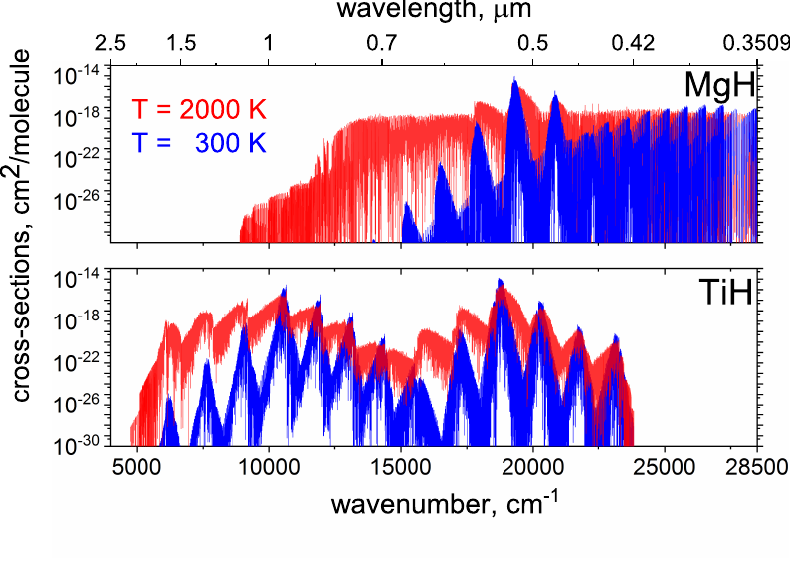
Figure 7. Absorption cross sections of MgH and TiH from GharibNezhad et al. [41] and Burrows et al.